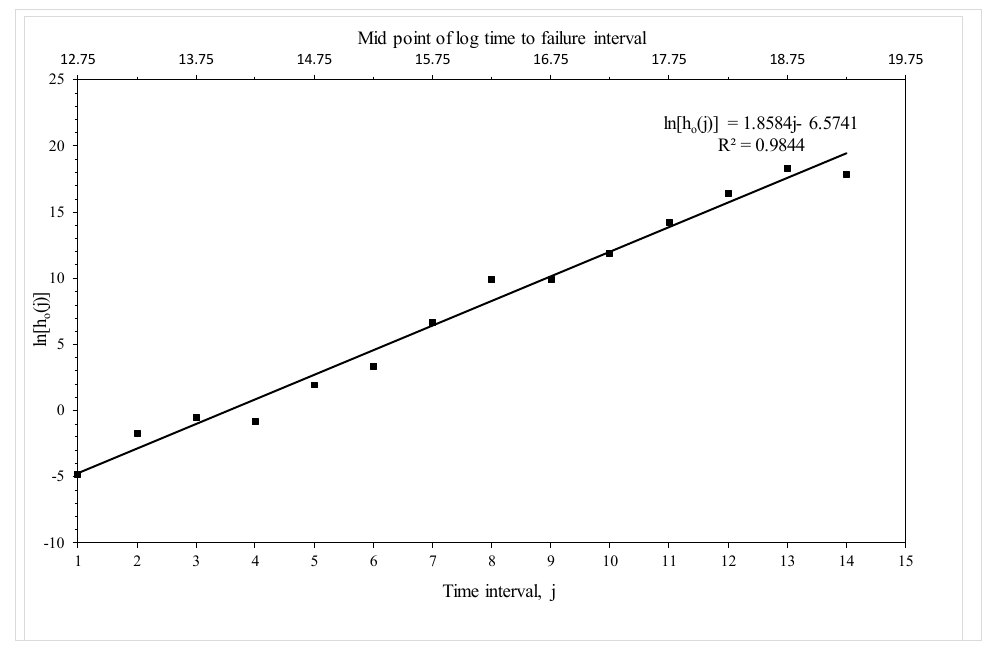
Figure 7. Estimated baseline (i.e., corresponding to 823 K and 294 MPa) piece-wise log hazard function based on Equation (19e).